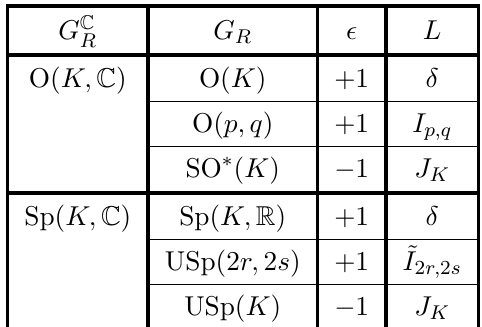
Table 3. In this table we list the real forms of the complex Lie groups O( K, C ) and Sp( K, C ) , which are the building blocks of the complex R-symmetry groups. Note that p + q = K and 2 r + 2 s = K . The third column specifies whether the reality condition which defines the real form provides the auxiliary space C K with a real structure ( (cid:15) = 1 ) or with a quaternionic structure ( (cid:15) = − 1 ). This decides which reality conditions are available to define a real structure on g C fourth column we list the standard or ‘canonical’ choices for the matrix L which defines the reality condition.